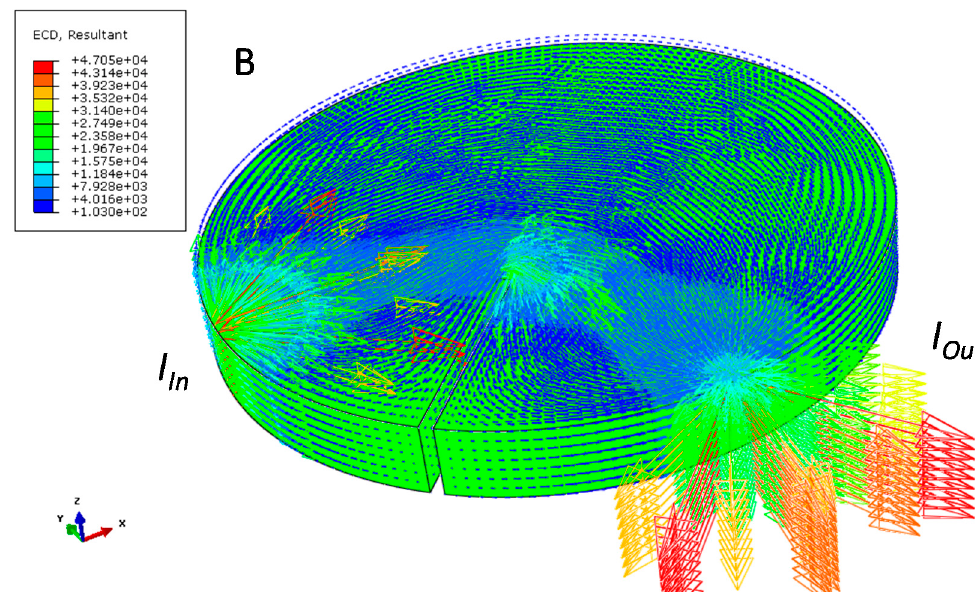
Figure 12. Representation of the current line on a sample containing radial crack; ( A ) probes placed on the same side of the crack; ( B ) probes placed on both sides of the crack. Table 3. Electrical resistivity of a sample containing a crack, normal to the axis of rotation, calculated using the FEM and VdP methods.